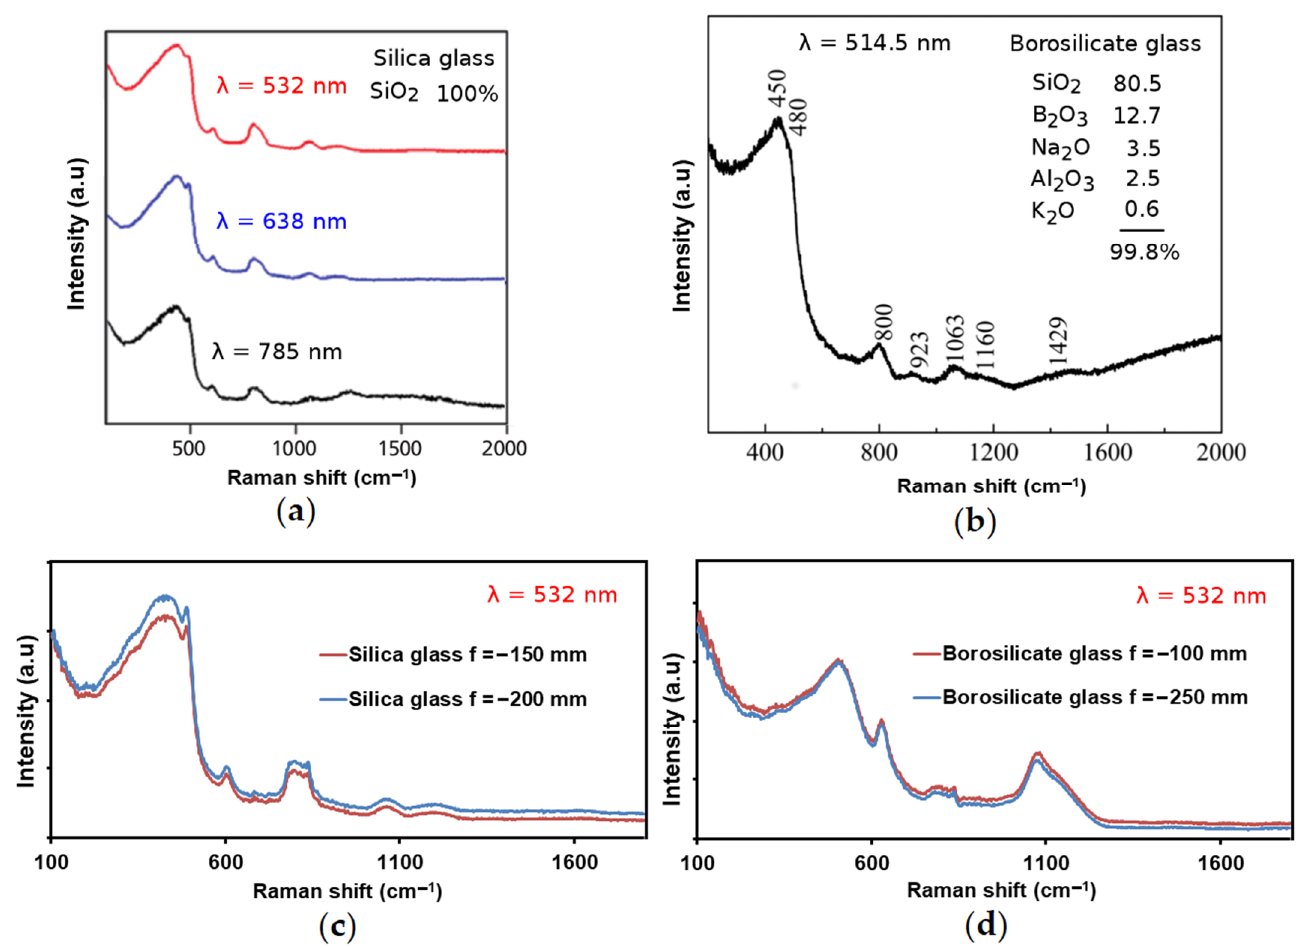
Figure 11. Raman spectra: ( a ) standard spectra for silica glass, measured with different excitation wavelength; ( b ) standard spectra for a borosilicate glass; ( c ) obtained Raman spectra in silica glass lenses of different focal length; ( d ) obtained Raman spectra in borosilicate glass lenses of different focal length.